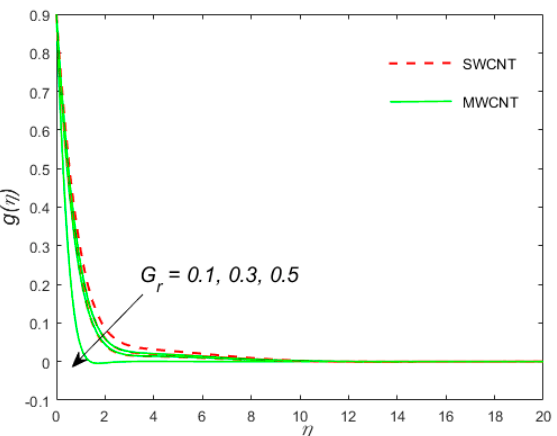
Figure 16. The variation of the concentration profile g( η ) for the case of SWCNT and MWCNT versus the similarity variable for the distinct values of the chemical response factor Gr .